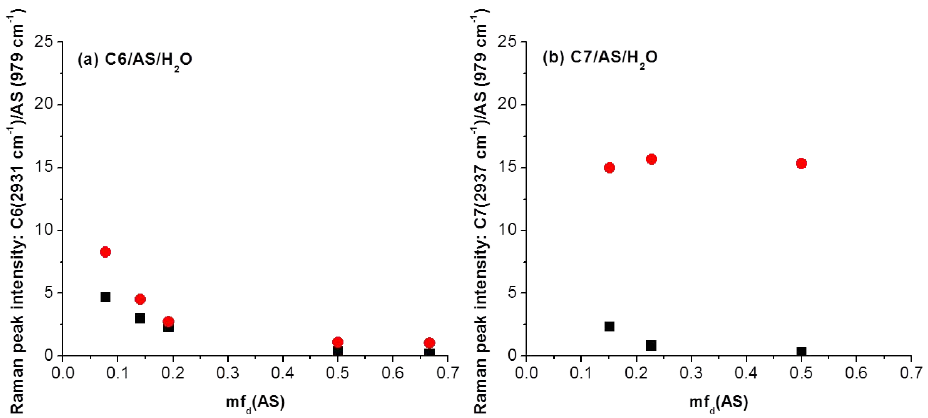
Fig. 6. (a) Ratios of C6 (2931cm − 1 ) to AS (979cm − 1 ) Raman peak intensities of a C6/AS/H 2 O particle in the one-liquid-phase state at RH=85% (black squares) and of the organic-rich phase in the two-liquid-phases state at RH=65% (red circles), and (b) ratios of C7 (2937cm − 1 ) to AS (979cm − 1 ) Raman peak intensities of a C7/AS/H 2 O particle in the one-liquid-phase state at RH=95% (black squares) and of the organic-rich phase in the two-liquid-phases state at RH=65% (red circles) as a function of the overall mf d (AS). that C6/AS/H 2 O systems with mf d (AS) below 0.3 do not exhibit a typical LLPS. This issue will be discussed in de- tail in Sect. 3.5.